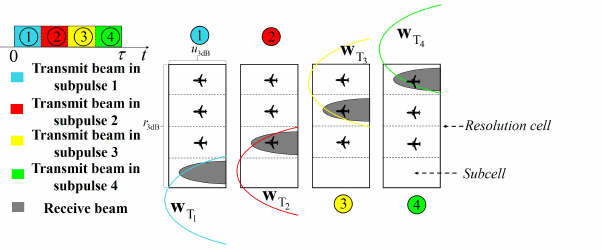
Figure 2. Intra-pulse beam scanning of transmit beampattern for unresolved